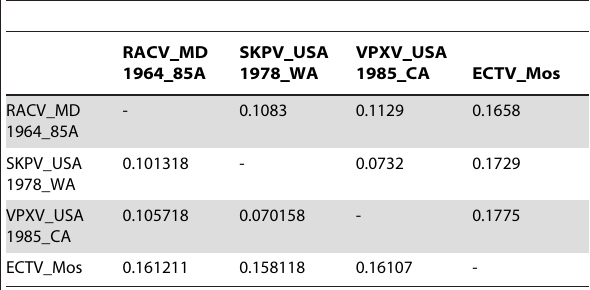
Table 1. Pairwise genetic distances* (lower) and patristic distances (upper).